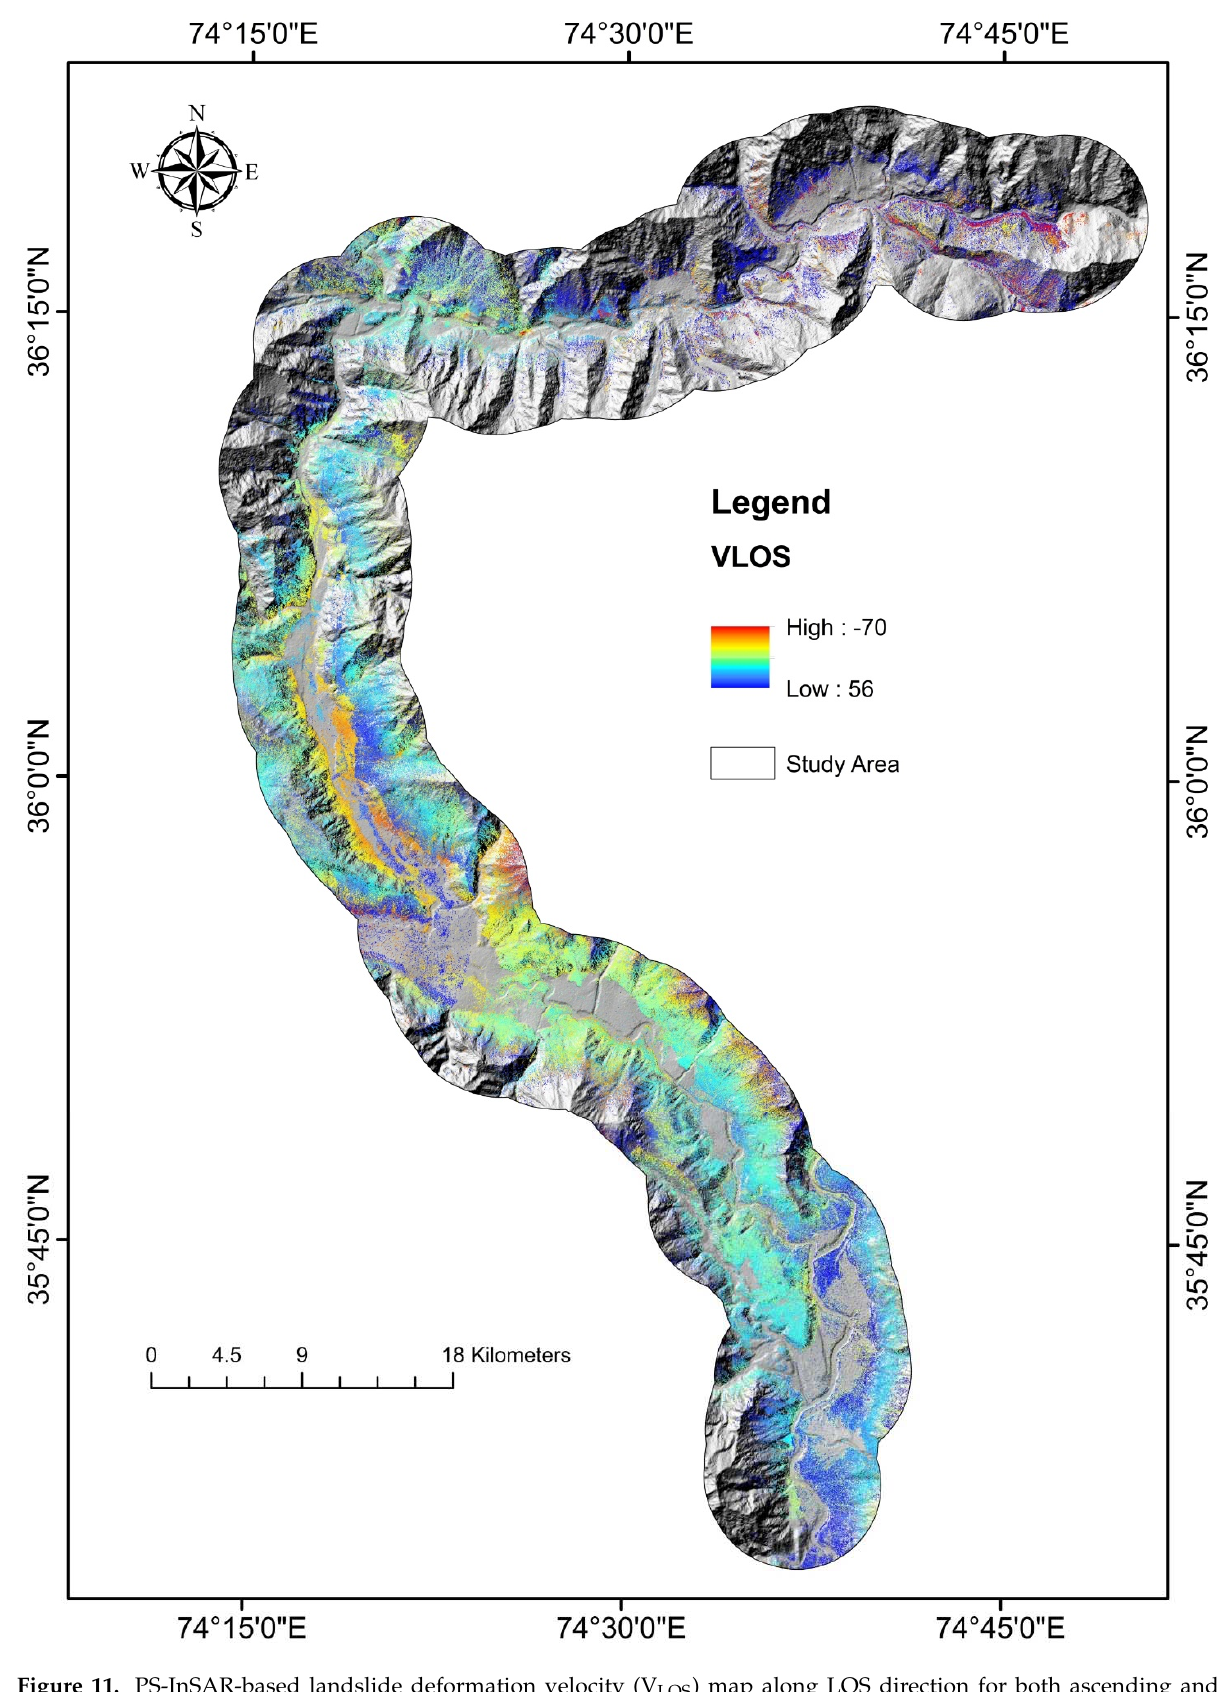
Figure 11. PS-InSAR-based landslide deformation velocity (V LOS ) map along LOS direction for both ascending and descending data .